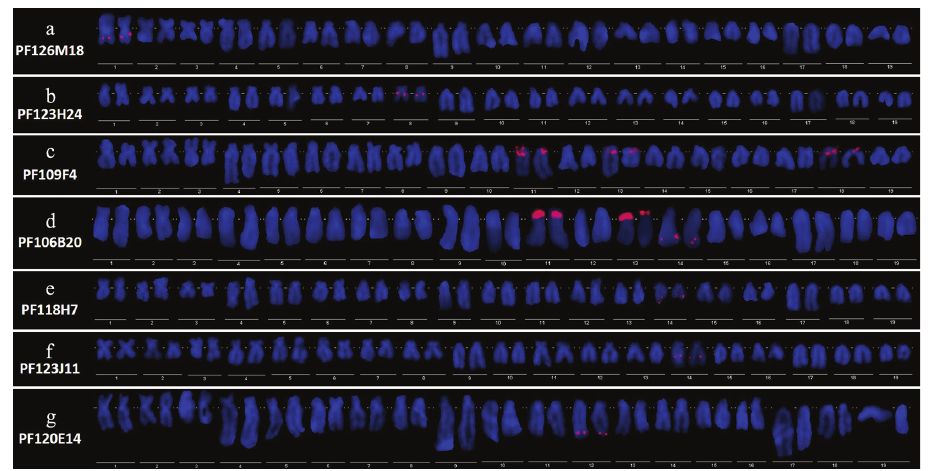
Figure 1. Karyotype analysis results of mapped gene-containing fosmid clones: PF126M18 ( A ); PF123H24 ( B ); PF109F4 ( G ); PF106B20 ( D ); PF118H7 ( E ); PF123J11 ( F ); PF120E14 ( G ). Chromo- some numbering is based on chromosome type and relative length. Wherein, chromosome pair 1, 2, 3 represent the metacentric (m) chromosomes. Chromosome pair 4, 5, 6, 7, 8 represent the submetacentric (sm) chromosomes. Chromosome pair 9, 10, 11, 12, 13, 14, 15, 16 represent the subtelocentric (st) chro- mosomes. Chromosome pair 17, 18, 19 represent the telocentric (t)